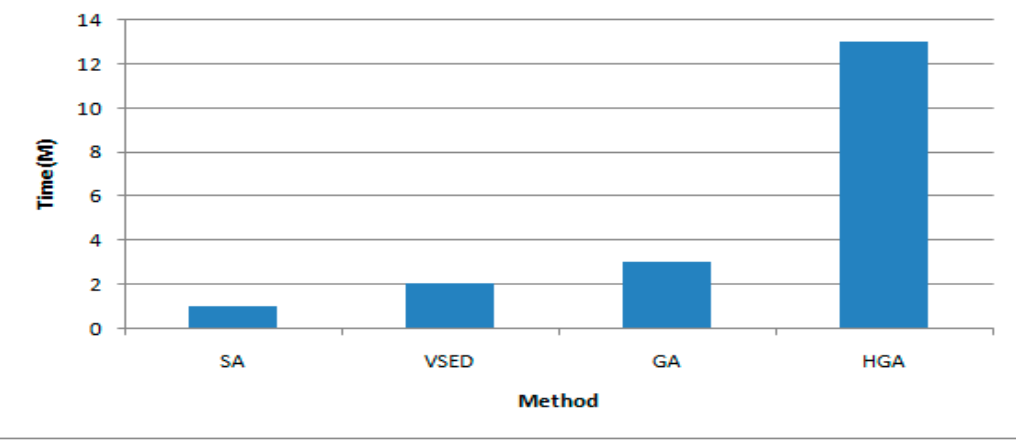
Figure 8. Search time comparison.